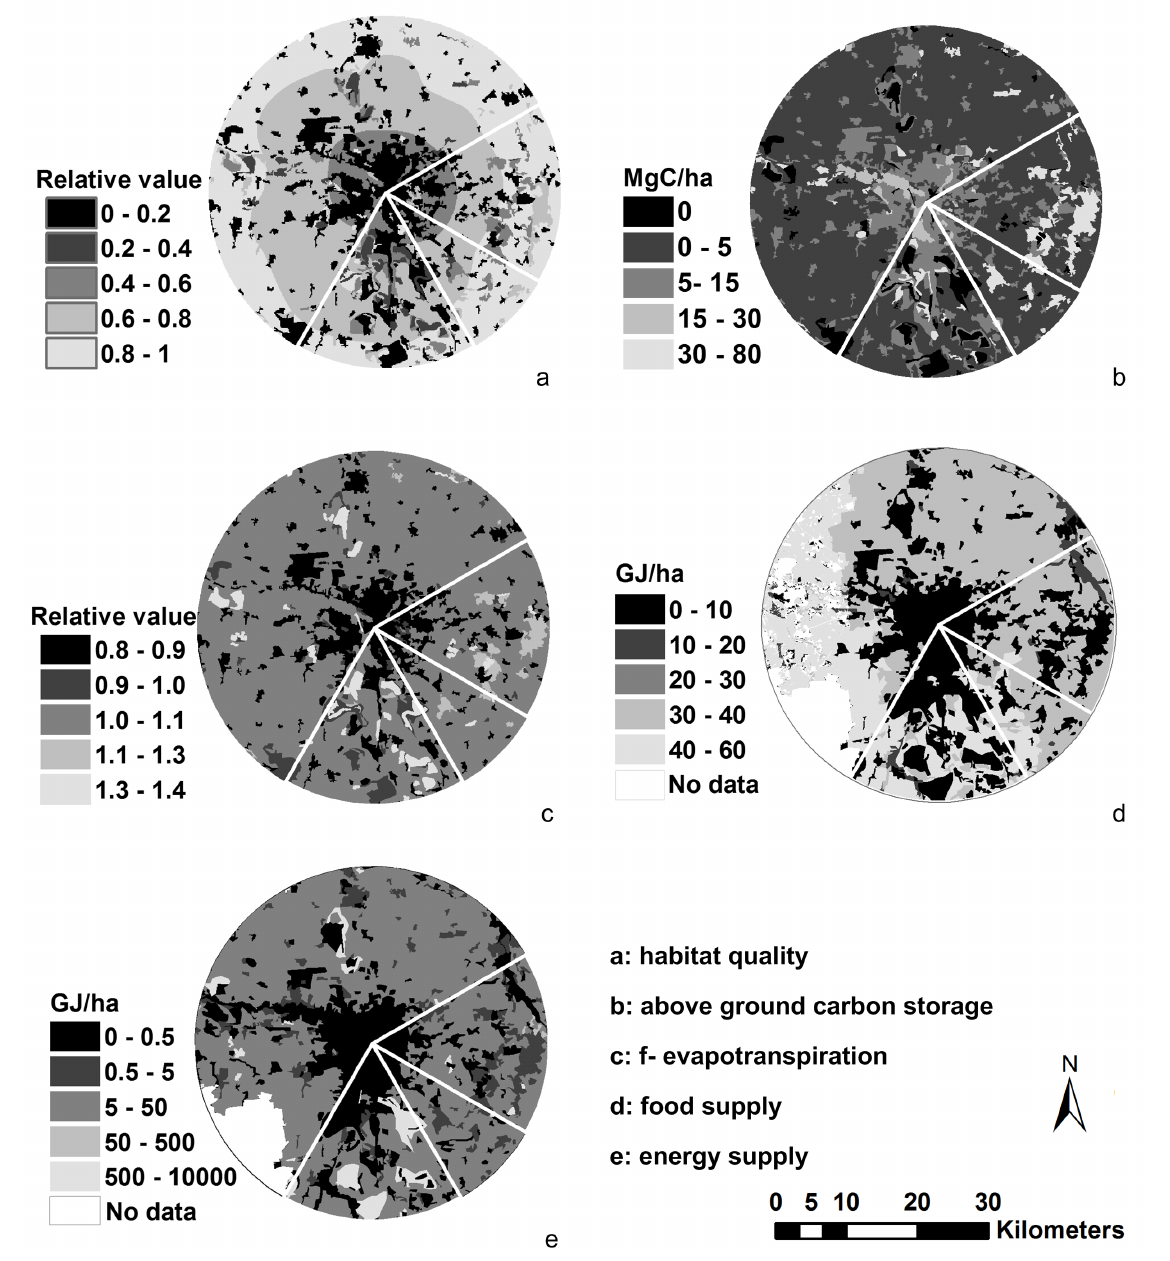
Figure 5: Spatial distributions of the five ecosystem services in the circle and sector areas of the Leipzig urban-rural gradient. a, b, c items are for 2006 and d, e items are for 2007 (d and e are adapted from Kroll et al.,